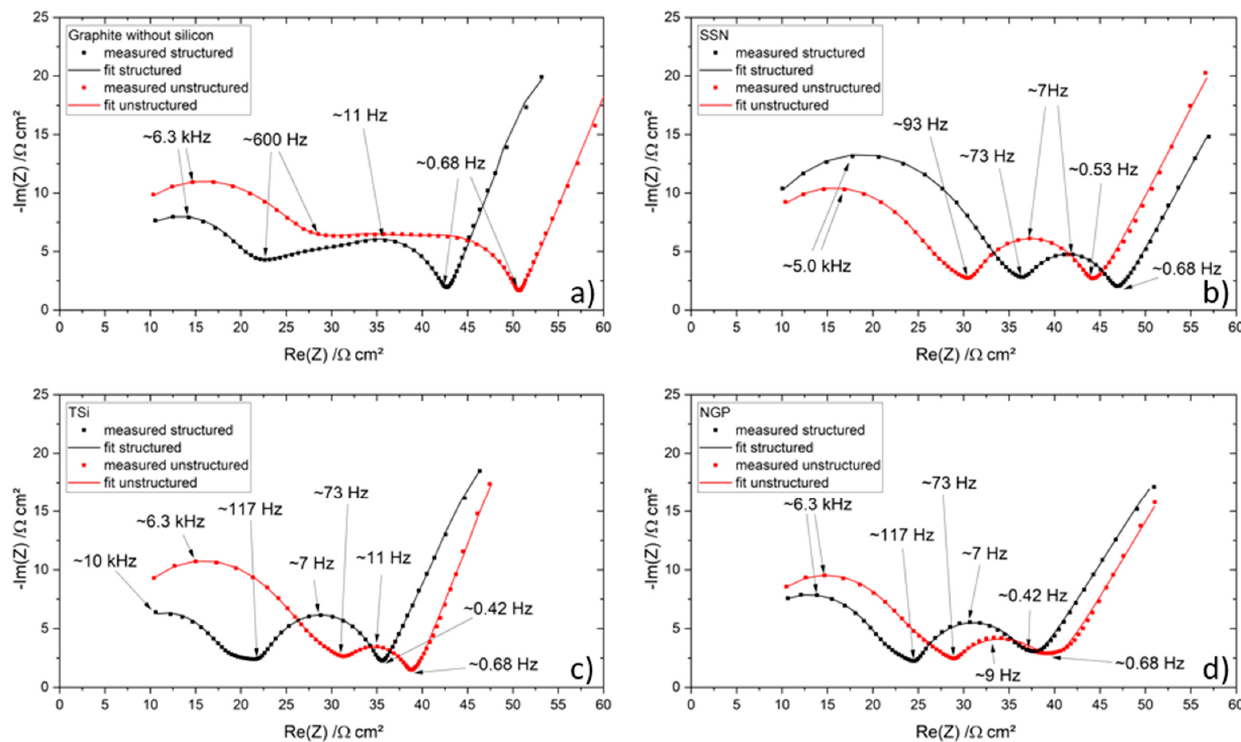
Figure 12. Electrochemical impedance spectra of the pouch cells after the formation step and their respective fit: ( a ) graphite, ( b ) SSN, ( c ) TSi, and ( d ) NGP anode.